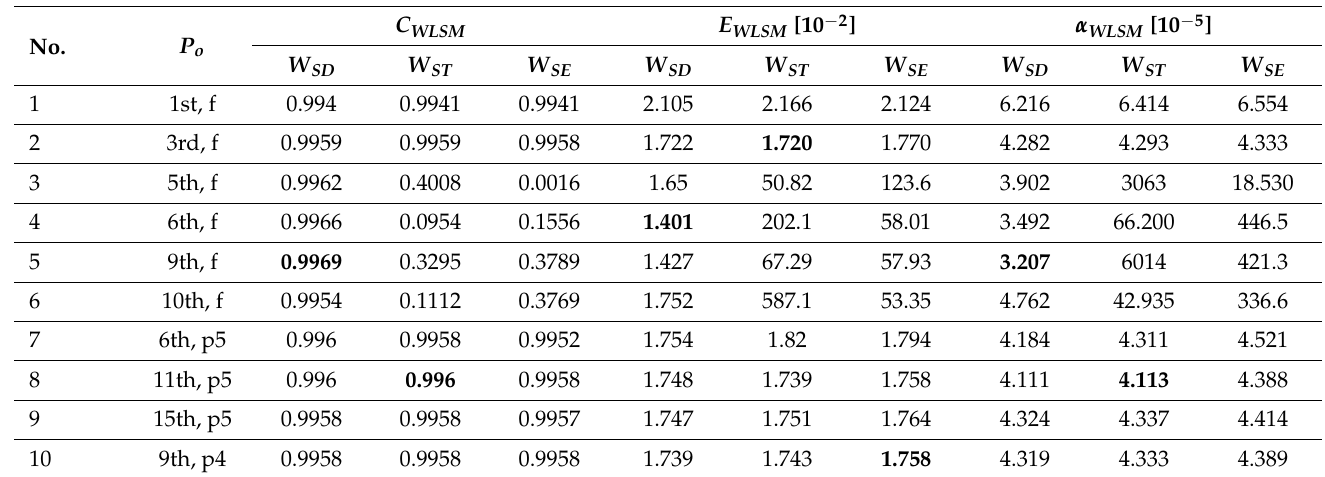
Table 2. Selected WLSM polynomial approximations of the extreme displacement versus random